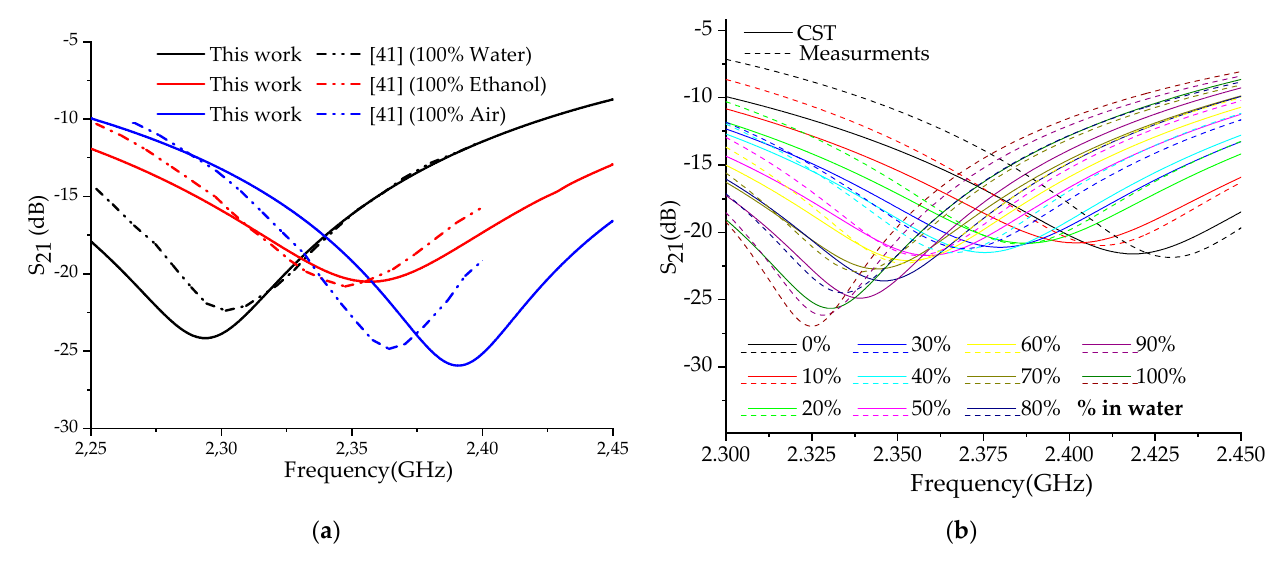
Figure 6. S 21 parameter simulations of ( a ) water, ethanol, and air samples of normal glass tube design compared to measurements [41]; ( b ) water–ethanol concentration of the designed parallel test tube compared to measurements.